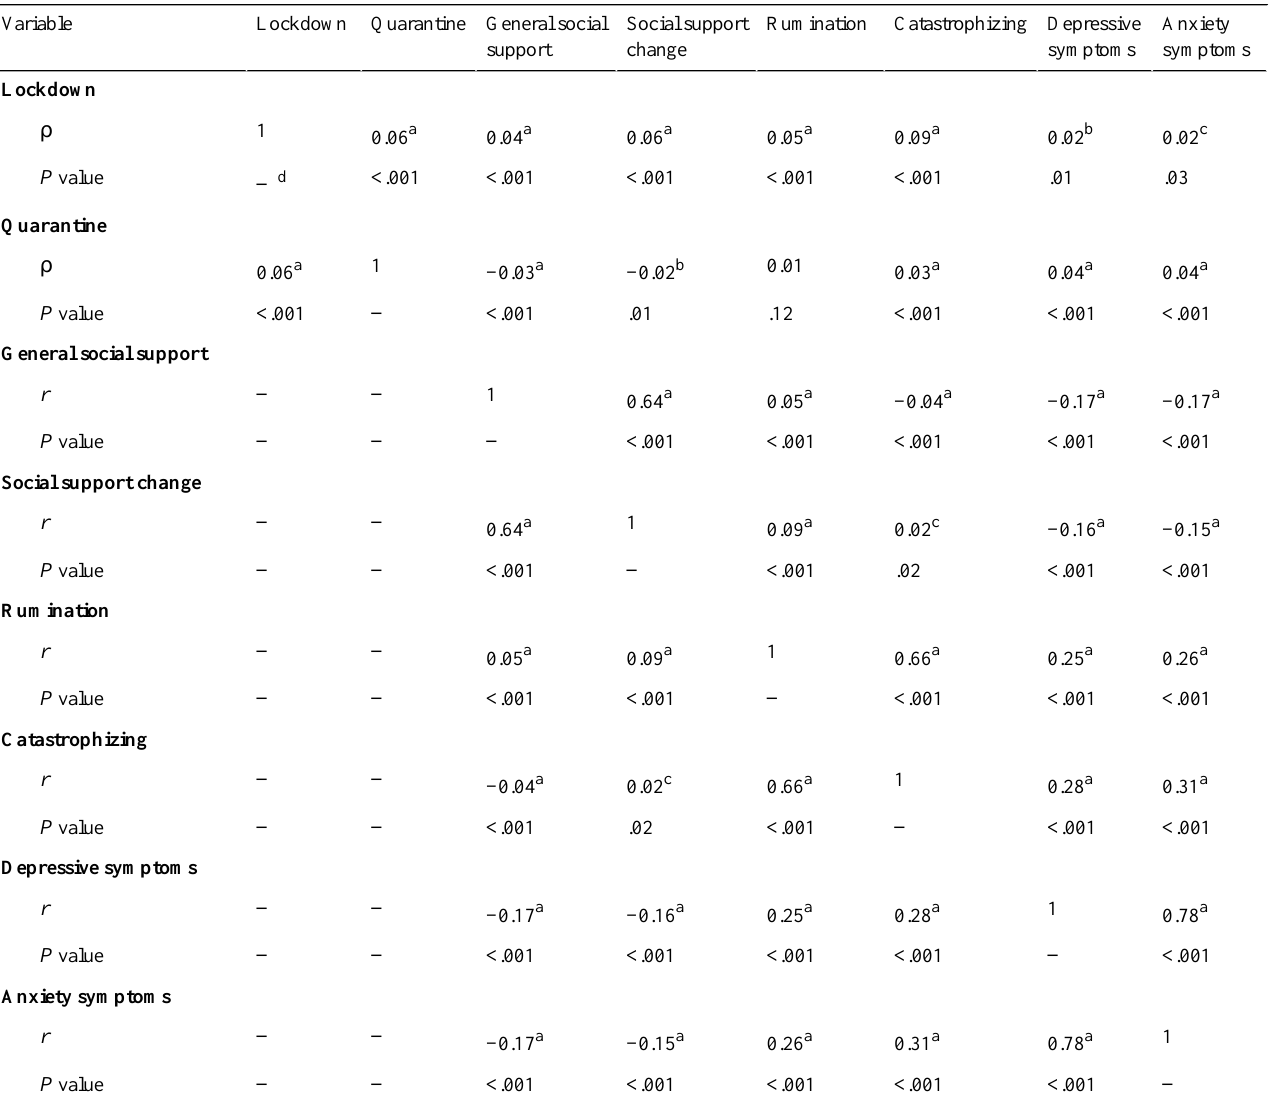
Table 6. Bivariate correlations (Spearman ρ , Pearson r , and P values) between the key psychosocial